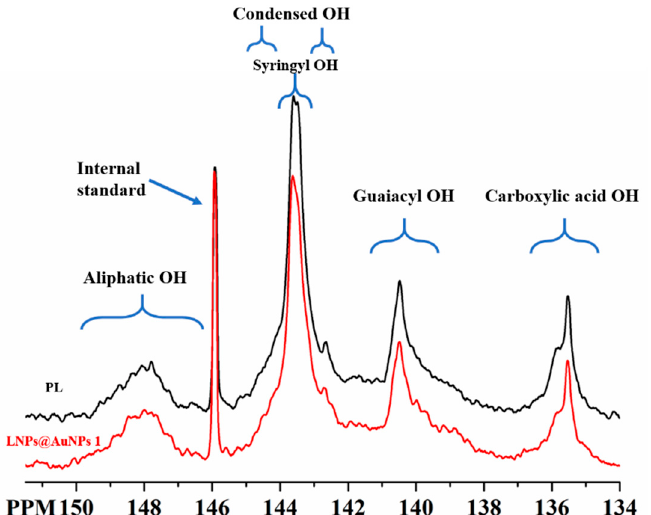
Figure 2. 31 P of the PL and LNPs@AuNPs 1.